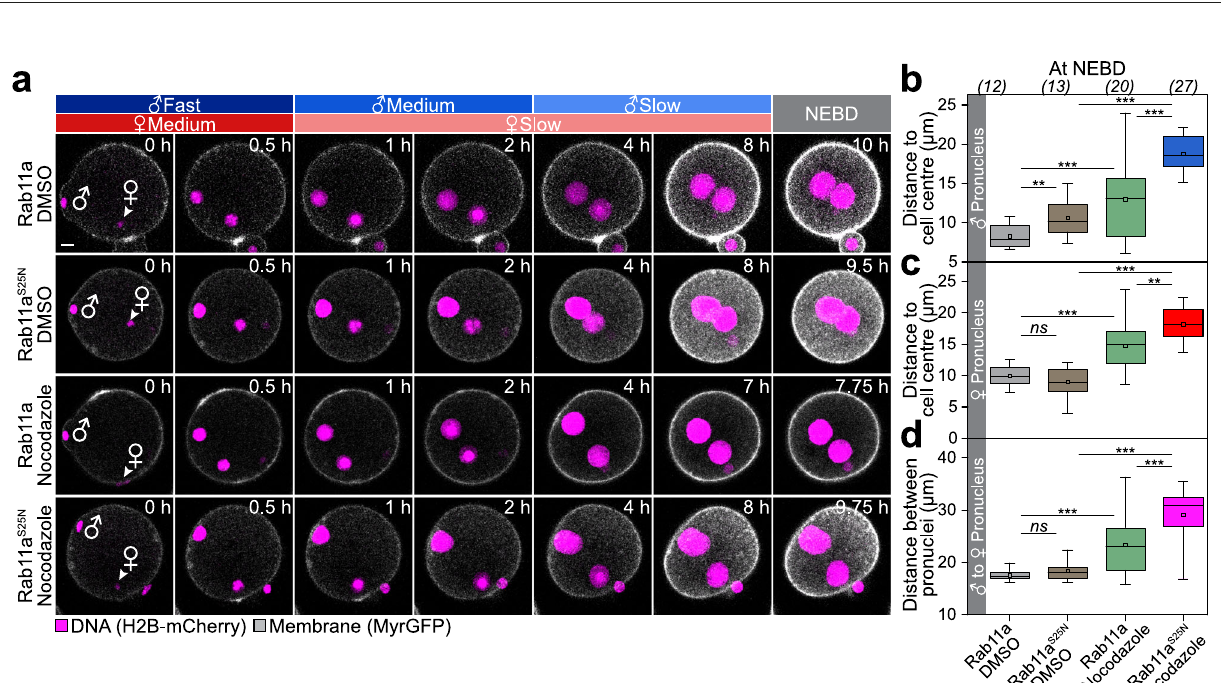
Fig. 9 Local actin nucleation by Spire and Formin-2 and microtubule-based transport drive pronuclear migration in a partially redundant manner. a Three-dimensional time-lapse images of pronuclei and the cell surface relative to pronuclear formation (0 h) in zygotes expressing SNAP-Rab11a or SNAP-Rab11a S25N and treated with DMSO or 10 µ M nocodazole, respectively. Female ( ♀ ) and male ( ♂ ) genomes are shown at pronuclear formation until nuclear envelope breakdown (NEBD). Phases of respective movement speeds are classi fi ed as in Fig. 1a. In 10/27 (37%) of Rab11a S25N nocodazole zygotes, we observed that cells adopted a severely squeezed shape during pronuclear migration pushing pronuclei located beneath the cell surface closer to cell centre, which may account for some movement of pronuclei indirectly to cell centre. Distance of male ( b ) and female ( c ) pronuclei centroids to zygote centre at NEBD in zygotes expressing SNAP-Rab11a or SNAP-Rab11a S25N and treated with DMSO or 10 µ M nocodazole, respectively, calculated from ( a ). Total number of analyzed zygotes (italics) was pooled from three independent experiments. Box plot showing median (line), mean (small square), 5th, 95th (whiskers) and 25th and 75th percentile (box). Two-tailed Student ’ s t test was used to test for signi fi cance (from top to bottom: b p < 0.0001, p < 0.0001, p = 0.0006 and p = 0.005; c p < 0.0001, p = 0.001, p < 0.0001 and p = 0.2). d Distance between male and female pronuclei centroids at NEBD in zygotes expressing SNAP-Rab11a or SNAP-Rab11a S25N and treated with DMSO or 10 µ M nocodazole, respectively, calculated from ( a ). Box plot showing median (line), mean (small square), 5th, 95th (whiskers) and 25th and 75th percentile (box). Two-tailed Student ’ s t test was used to test for signi fi cance (from top to bottom: p < 0.0001, p = 0.0008, p = 0.0002 and p = 0.2). Scale bars, 10 μ